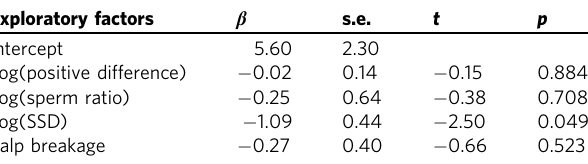
Table 4 The best fi tting GLMM model including tree fi xed effects (SSD, positive difference in sperm number, sperm ratio and sexual size dimorphism, and palp breakage) and one random effect (male identity) to predict the palp